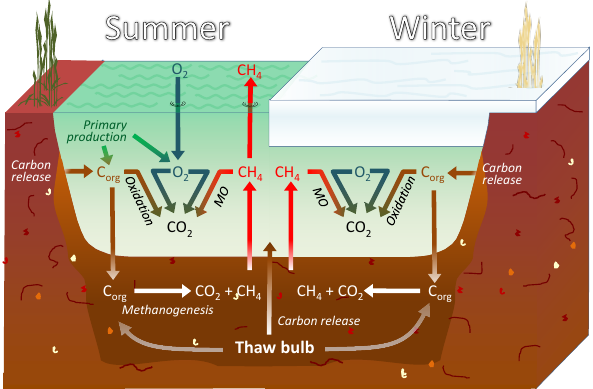
Figure 1. Carbon cycling in northern high-latitude lakes during the summer and winter. Carbon (C org ) release from primary production and landscape processes promotes CH 4 production and competes with MO for O 2